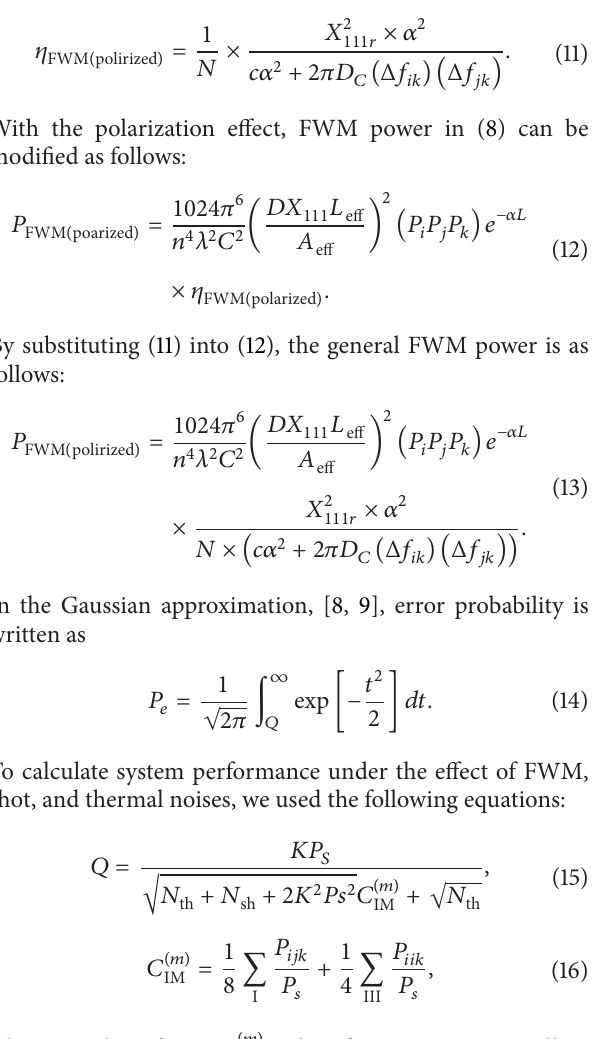
Figure 4: Optimum eye diagram performance of SMF using ch 1 (a) without polarization technique and (b) with polarization. Both at 𝑃 14